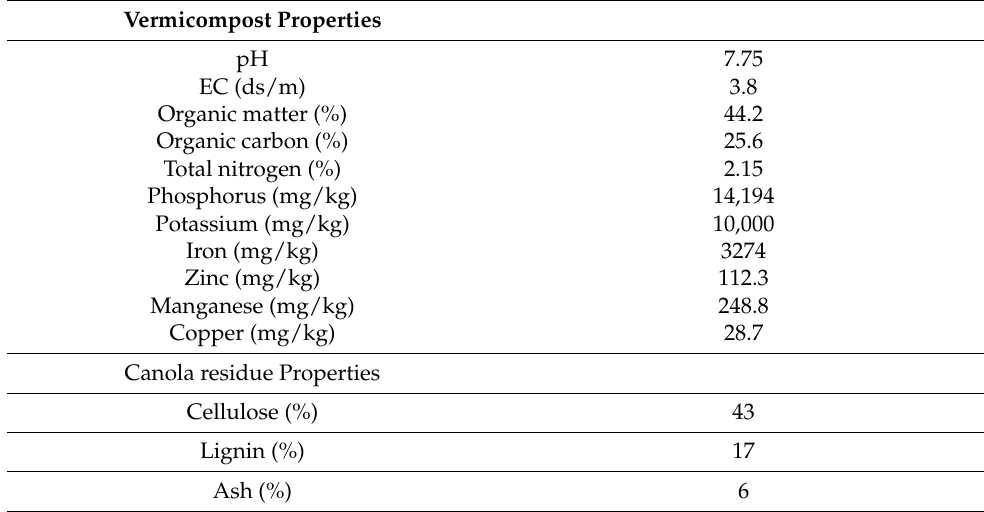
Table 1. Some chemical characteristics of vermicompost